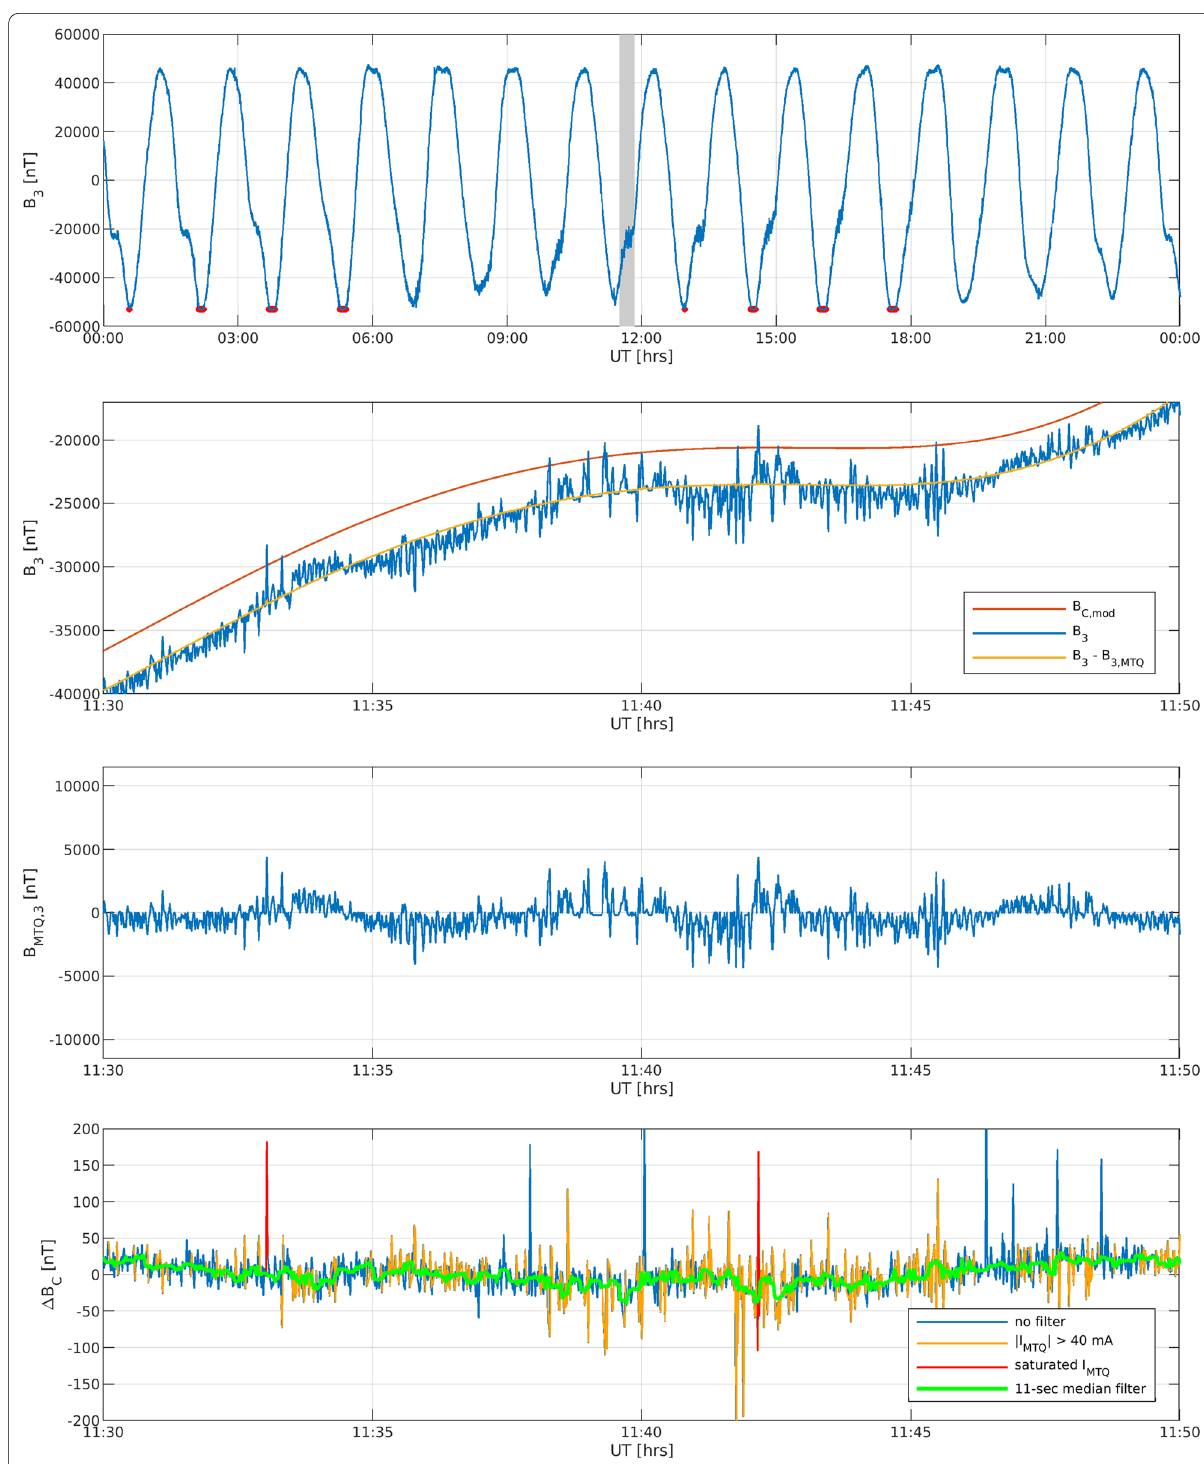
Fig. 3 GRACE-A magnetic data on 2. February 2014. Top: raw (uncalibrated) readings of the 3rd magnetometer sensor for that day. 2nd panel: 20-min window before (blue) and after (orange) correcting for magnetorquer disturbances shown in the 3rd panel. Bottom: fully calibrated downward magnetic field component B C after removal of CHAOS-7 model values. See text for